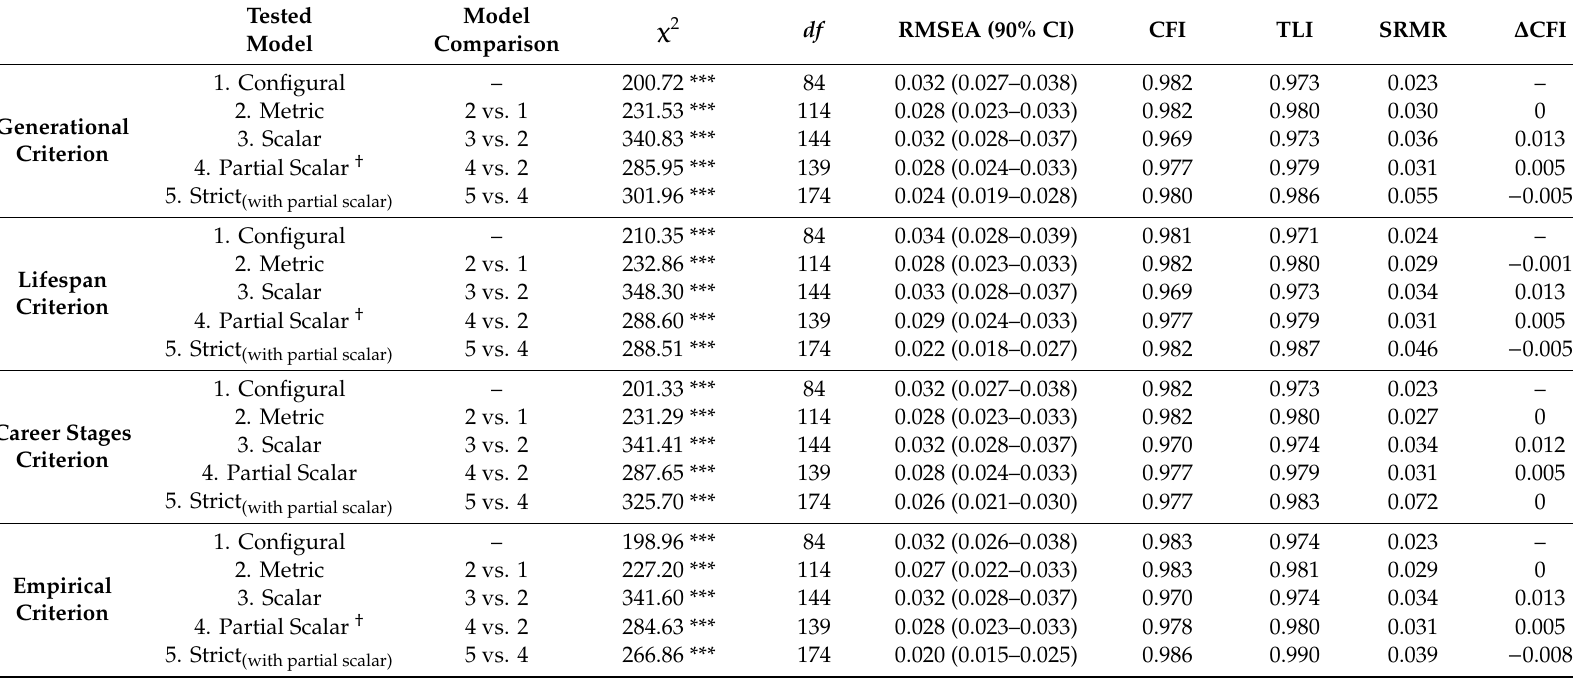
Table 4. Measurement invariance of the single-factor model across age*employment status groups derived with di ff erent criteria for age